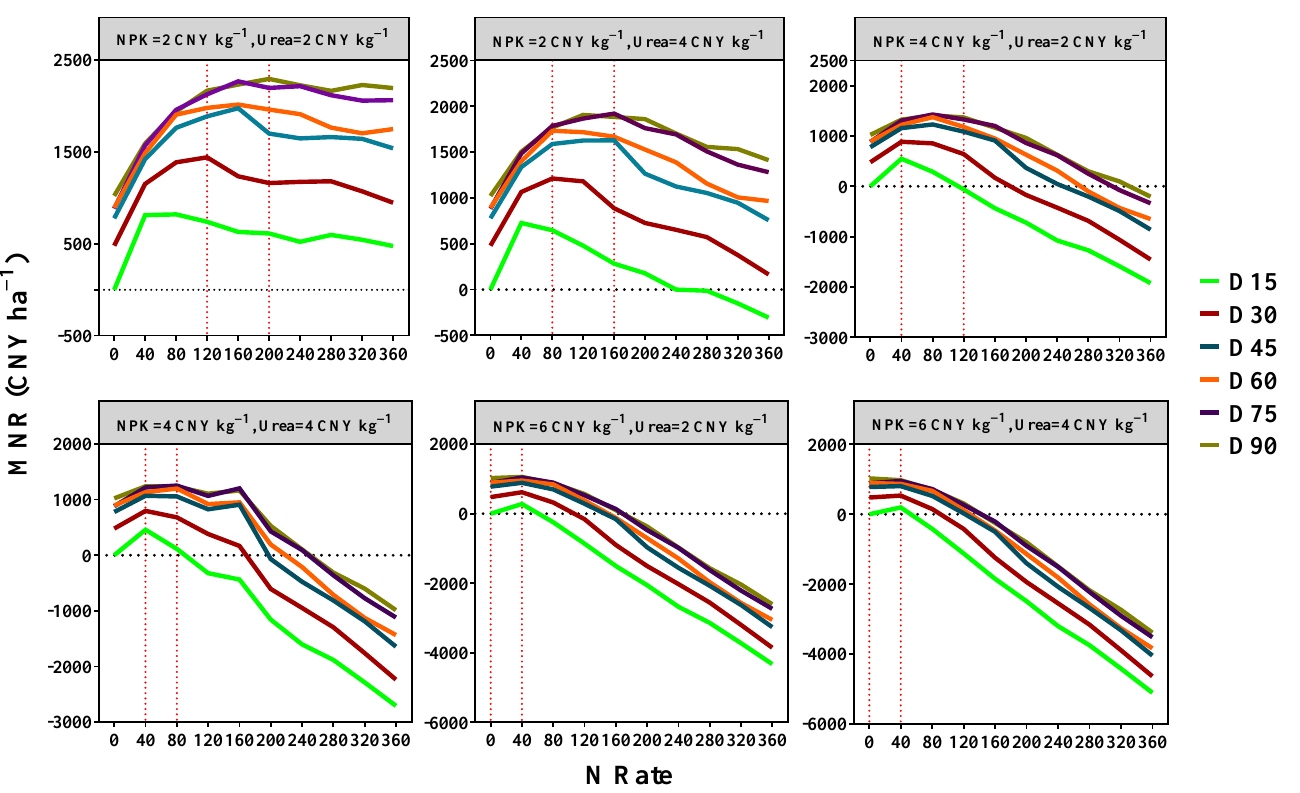
Figure 7. Simulated marginal net return under different nitrogen rates, N fertilizer prices and planting densities over 30 seasons (the normal price was NPK compound fertilizer = 2 CNY kg −1 ; urea = 2 CNY kg −1 ; and the range in between the red dotted lines represents the optimal nitrogen rate).